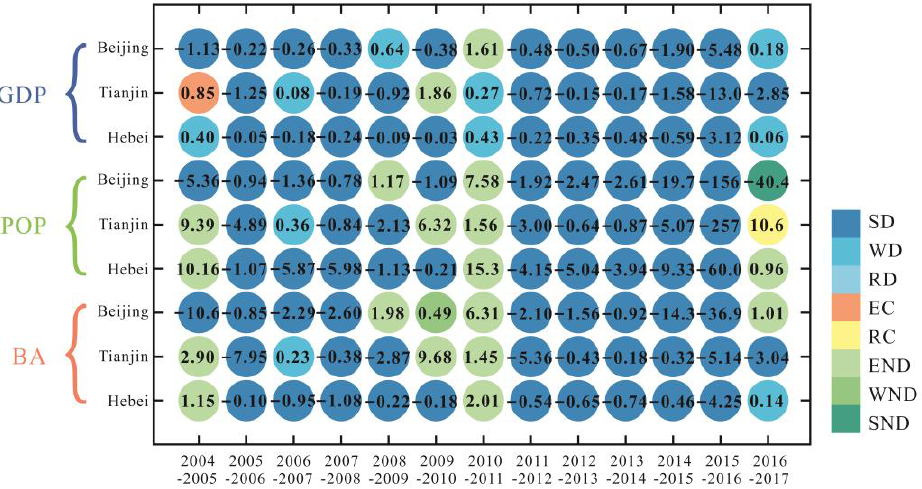
Figure 9. Decoupling state of VWF and GDP, POP, BA in the BTH region. The value is the decoupling index (D, calculated by Equation (12)).